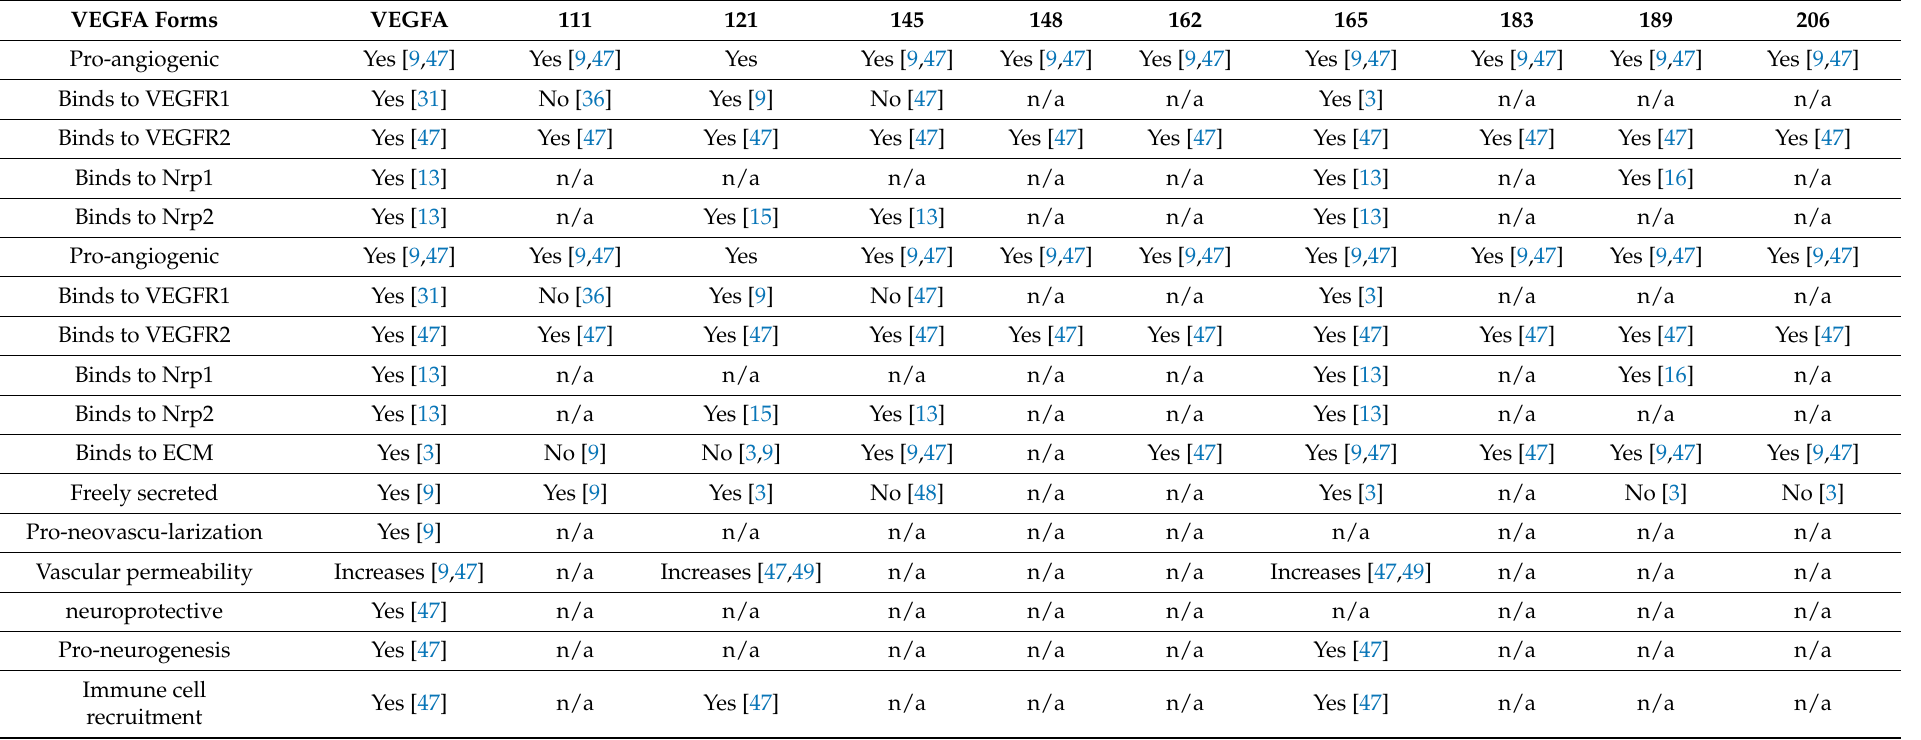
Table 2. Comparison of biological effects of VEGFA isoforms to known functions of VEGFA. Vascular endothelial growth factor A (VEGFA) and its isoforms’ effects on cells, as well as their binding capacities to VEGFR1, VEGFR2, and the ECM. VEGFR: Vascular Endothelial Growth Factor Receptor. ECM: Extracellular